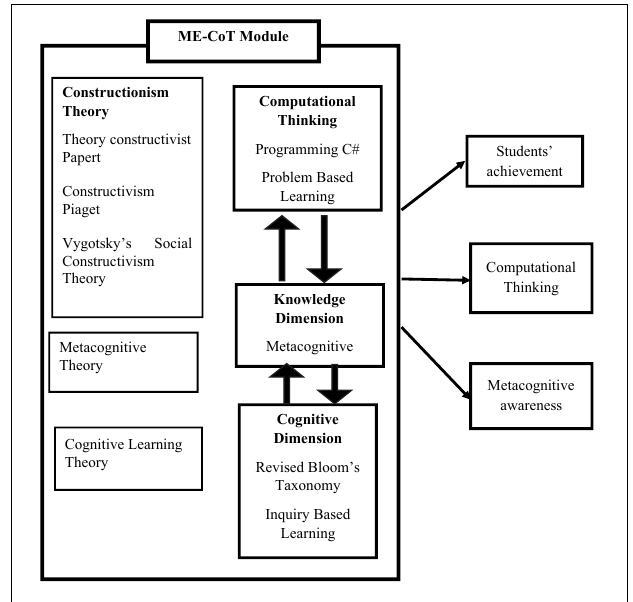
FIGURE 4 | Conceptual framework of the